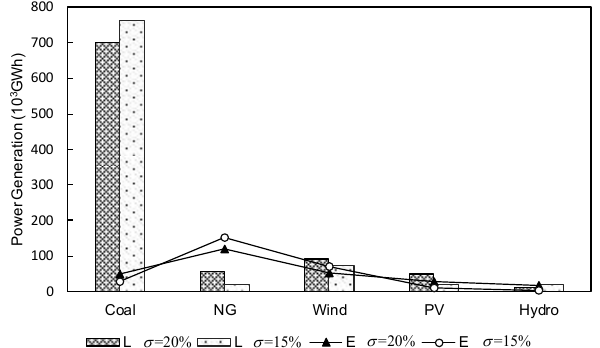
Figure 10. Comparison of power generations under two share scenarios. Note: L: local; E: export.